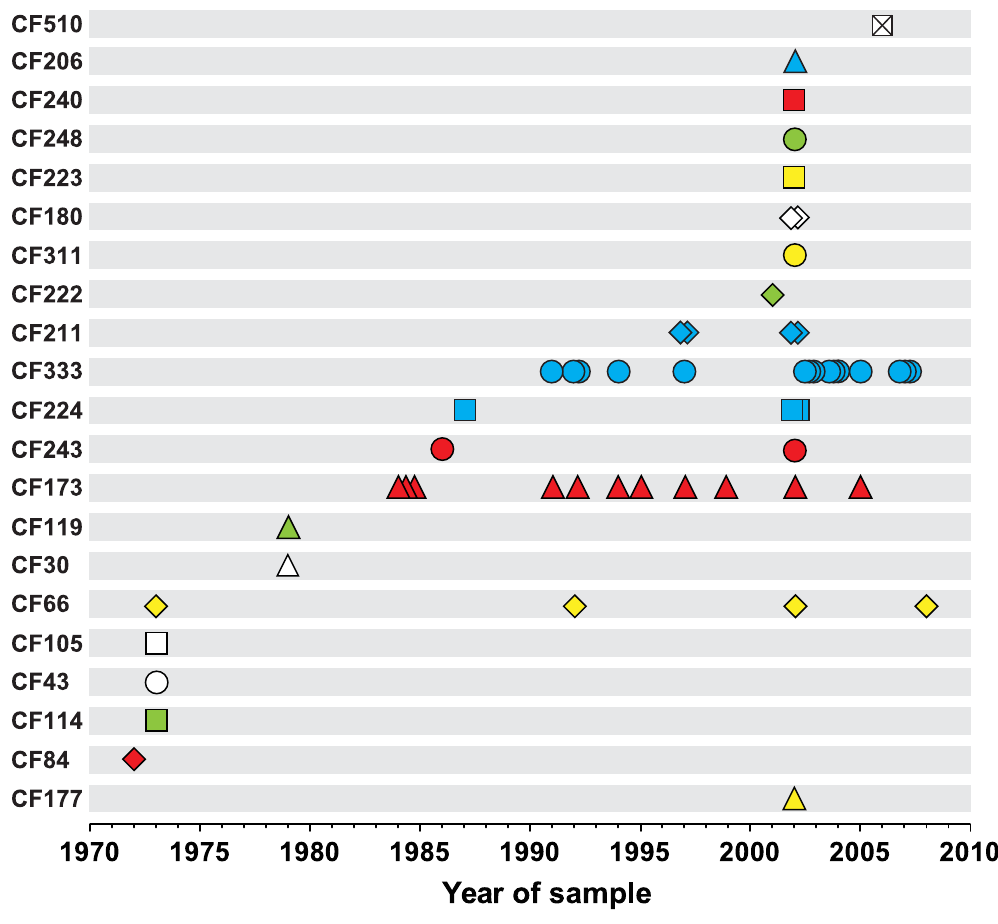
Figure 1. Patient origin and sampling time of genome sequenced P.aeruginosa DK2 isolates. The collection of 55 P. aeruginosa isolates of the DK2 clone type was sampled from 21 different CF patients over 38 years. Bacterial isolates are indicated by symbols, and if multiple isolates were sampled the same year from a patient, they are represented by stacked symbols. The isolates are named from the patient from whom they were isolated, and their isolation year ( e.g. isolate CF173-1991).